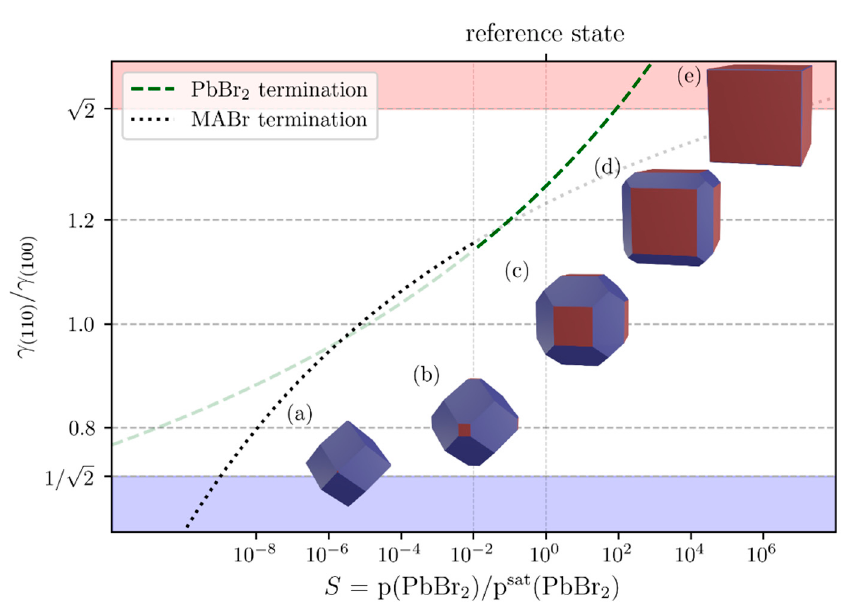
Figure 8. Dependence of the quotient r of the surface tensions for (110) and (100)-surfaces on the saturation number S . This is shown for the PbBr 2 -terminated surfaces (Figure 7a,c) (green dashed lines) and for the MABr-terminated surfaces (Figure 7b,d) (black dotted lines). Since the MABr termination below S = 1.0 · 10 − 2 is thermodynamically more stable than the PbBr 2 termination, the green dashed curve below this value and the black dotted curve above this value are drawn transparently. For five quotients, 3D-Wulff constructions of cubic crystallites ( a – e ) with (100) (red) and (110)-surfaces (blue) were shown, with the (100)-surface becoming more and more dominant for higher γ ( 110 ) / γ ( 100 ) -values. For geometric reasons, below a quotient of r = 1/ 2, i.e., in the blue region, the (100)-facet and above a quotient of r = 2, i.e., in the red region, the (110)-facet (PbBr ) , the thermodynamically more stable termination discussed in Table 1 (cid:1840) (cid:2915)(cid:2934)(cid:2913)(cid:2915)(cid:2929)(cid:2929) (cid:2870)